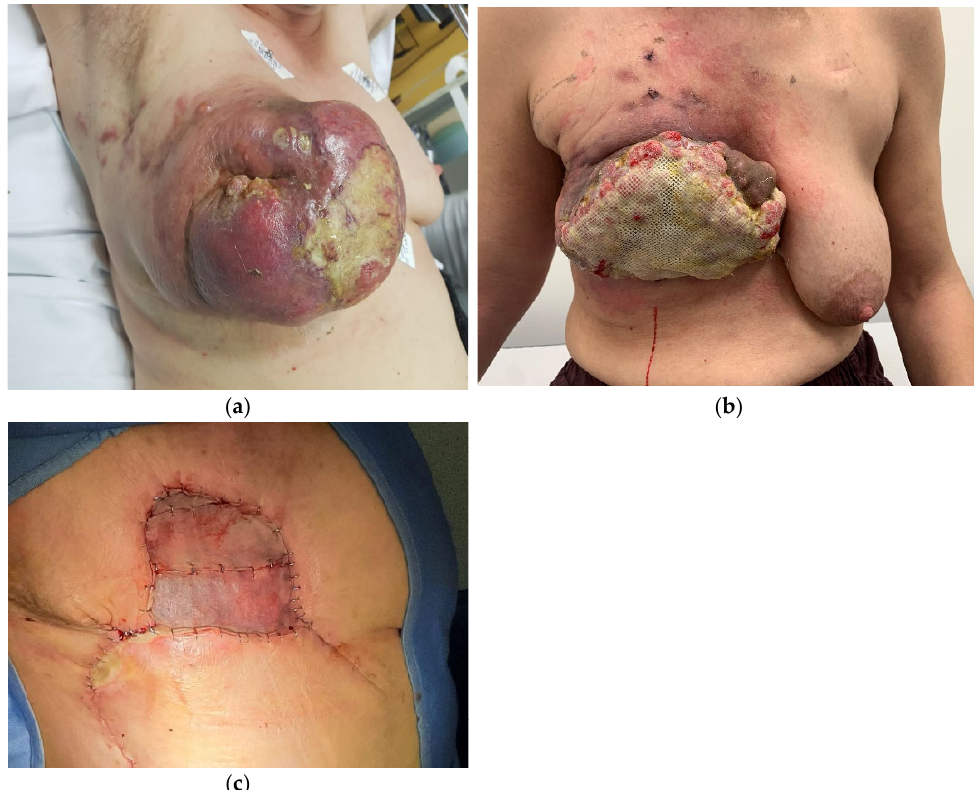
Figure 2. ( a ) Local conditions to admission into the Emergency Department; ( b ) Local conditions post ‐ NAC: NAC resulted in a modest reduction in the size of the neoplasm ( c ) Local conditions post ‐ surgery: surgery consisted of excision of the tumor, application of VAC therapy, and subsequent closure of the wall defect with a skin graft from the leg.